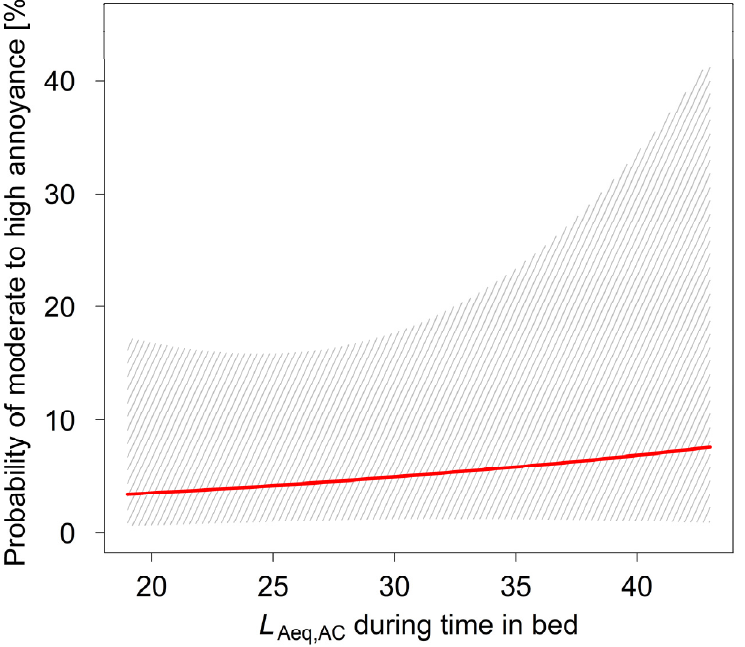
Figure 2. Probability for annoyance (categories ≥ 3) by aircraft noise of the previous night as predicted by model LR2 depending on the energy equivalent noise level for aircraft noise ( L Aeq,AC ) during time in bed. The hatched area shows the 95% CI.